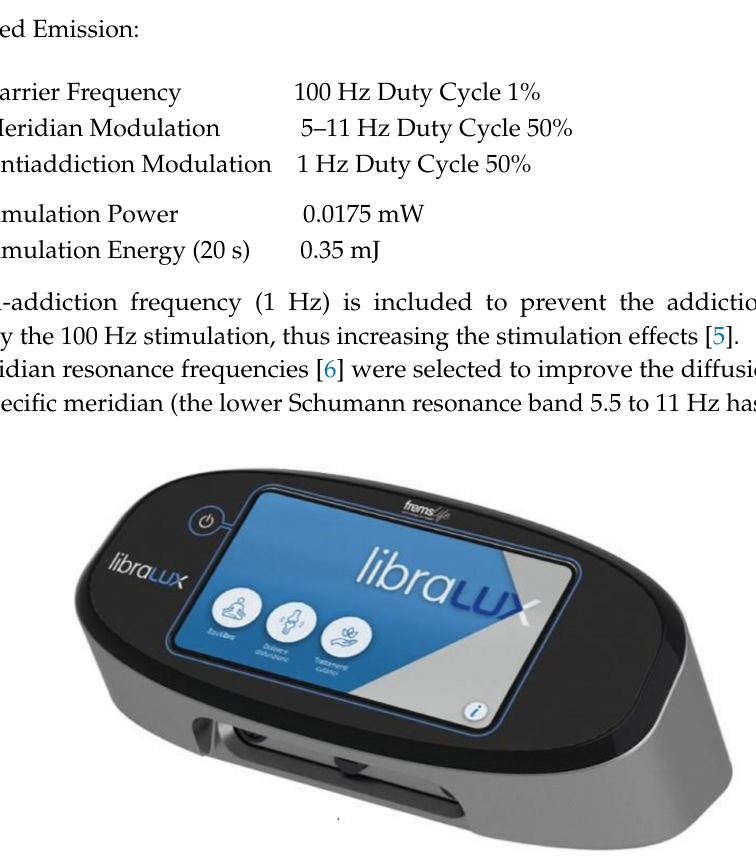
Figure 2. Libralux. (Image by courtesy of Fremslife srl—Genoa,